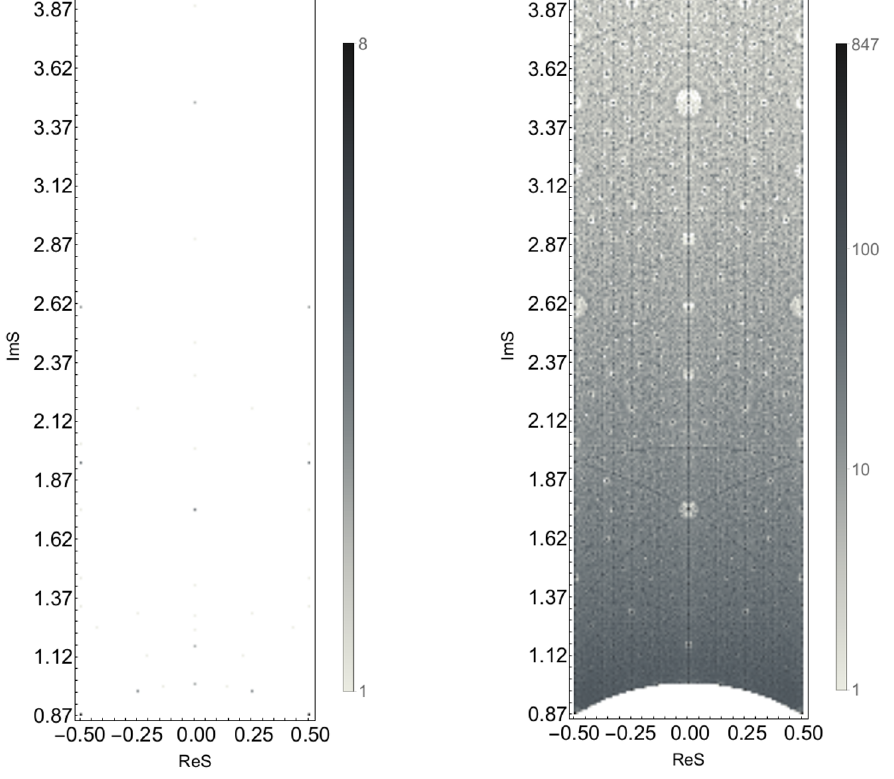
= 10 in the left panel (cid:13)ux